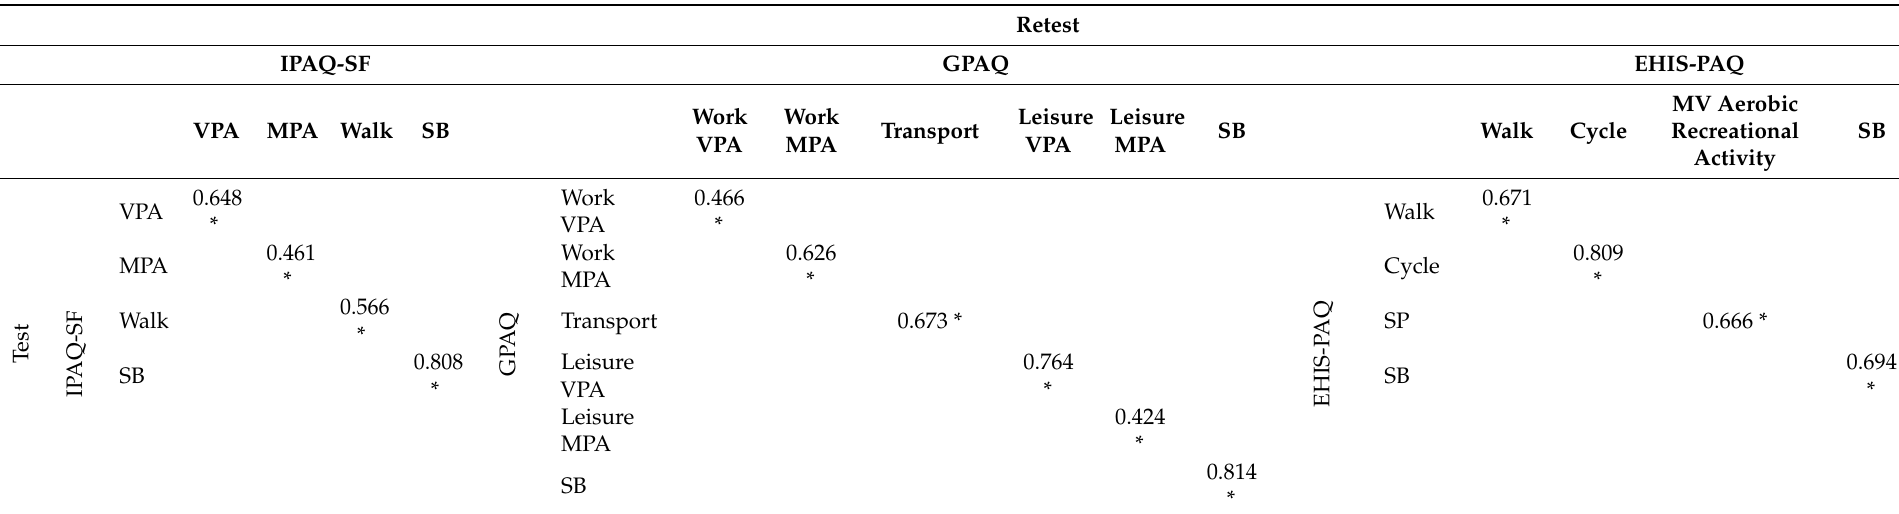
Table 2. Test-retest reliability of IPAQ-SF, GPAQ, and EHIS-PAQ.